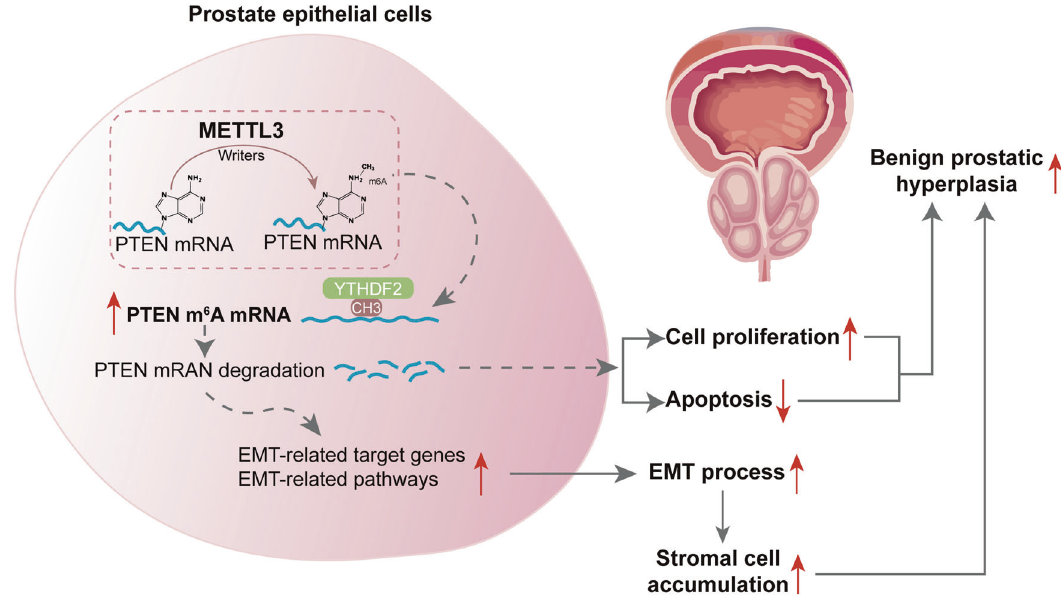
Fig. 8 A schematic diagram indicates the mechanisms of how METTL3 promotes prostatic hyperplasia of BPH. The METTL3/YTHDF2/PTEN axis disturbs the balance between epithelial proliferation and apoptosis, promotes EMT, and accelerates BPH development in an m 6 A modi fi cation-related